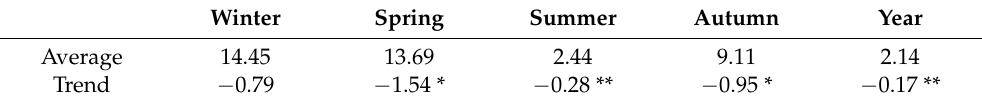
Table 6. The linear trends of annual and seasonal mean aridity index in China from 1961 to 2020. Winter Spring Summer Autumn Year Average 14.45